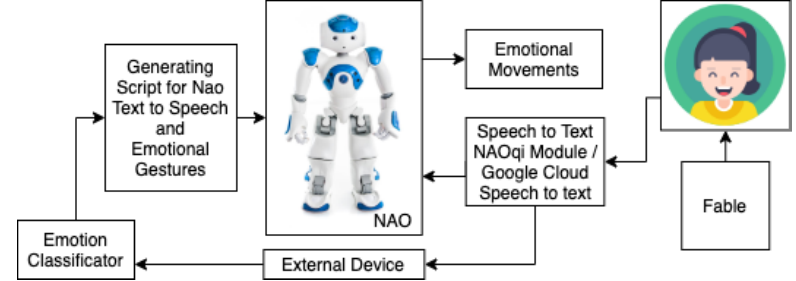
Figure 12. Setup for experiment 2.